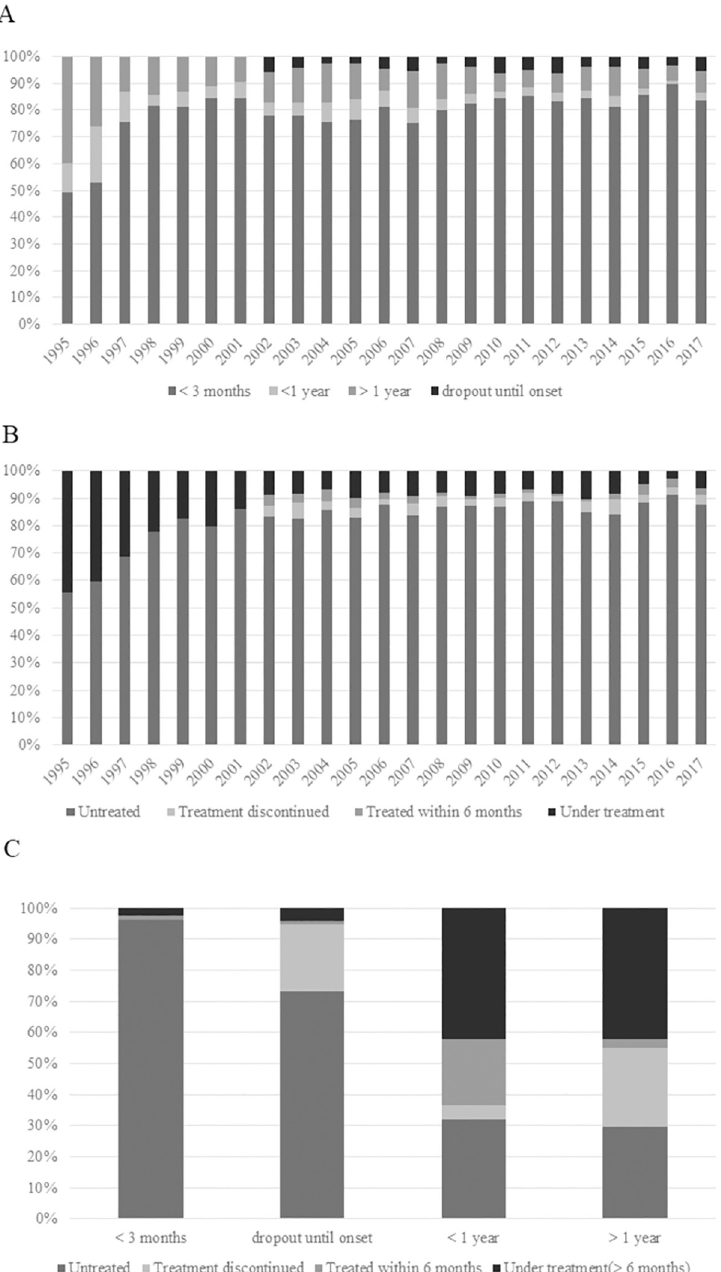
Fig 3. Status of human immunodeficiency virus (HIV) diagnosis and antiretroviral therapy (ART) at the onset of AIDS-defining illnesses (ADIs). (A) Time from HIV diagnosis to the onset of ADIs. The largest proportion of patients with ADIs were diagnosed within 3 months before and after HIV diagnosis. (B) Status of ART at the onset of ADIs. Most (87.8%) patients were not receiving ART at the onset of ADIs. (C) Time from HIV diagnosis to symptom onset (2002–2017). Relationship between time from HIV diagnosis to the onset of ADIs and use of ART. Most patients diagnosed with ADIs within 3 months after HIV diagnosis and those dropped out until ADI onset were untreated or had discontinued